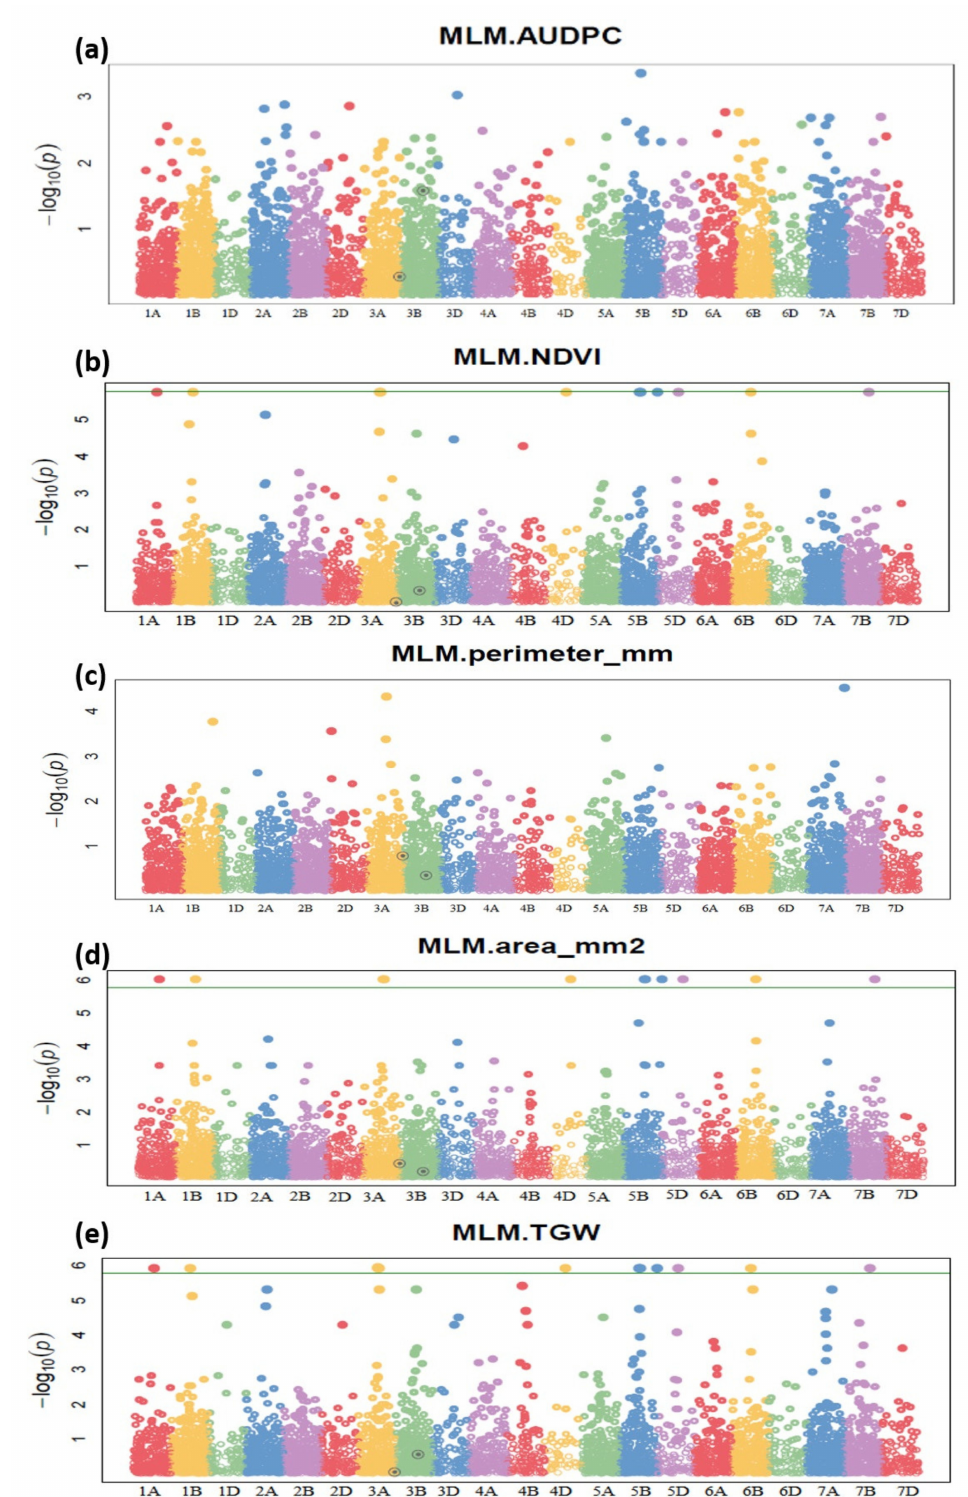
Figure 3. Genome-wide association scan for ( a ) area under disease progress (AUDPC), ( b ) normalized distributed vegetation index (NDVI), ( c ) grain perimeter, ( d ) grain area, ( e ) thousand-grain weight in RILs. The Manhattan plot was developed using a mixed linear model (MLM). The − log10 ( p ) values from a genome-wide scan are plotted against positions on each of the 21 wheat chromosomes. Horizontal lines indicate genome-wide significance